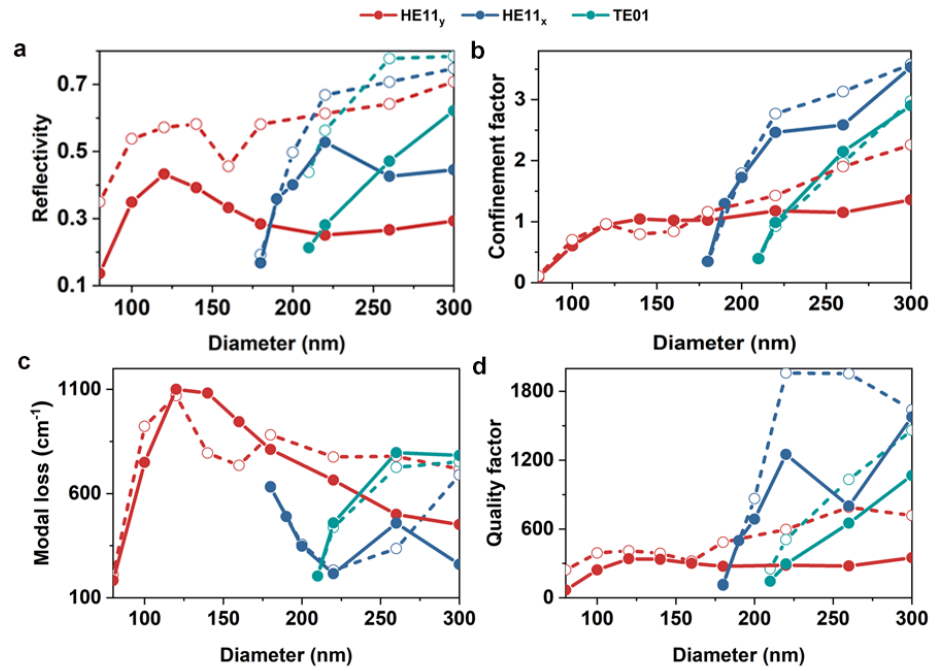
Figure 5. End facet reflectivity ( a ) and modal confinement (CF) ( b ) versus NW diameter for the SPP Laser (solid lines) and SPPG Laser (dash lines). ( c , d ) Modal loss and Q factor versus NW diameter for the SPP Laser (solid lines) and SPPG Laser (dash lines).